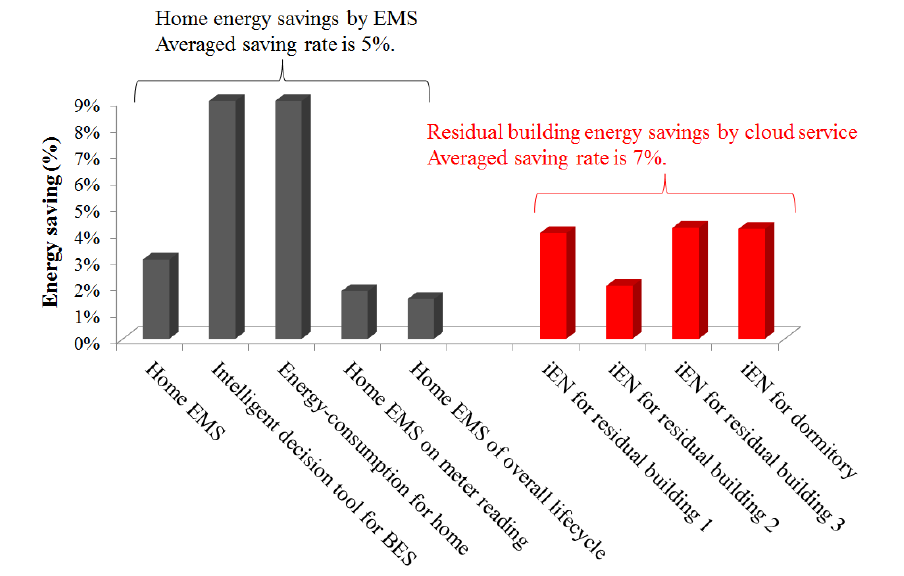
Figure 5. Comparison of energy savings for home-type buildings by applying EMS and iEN.